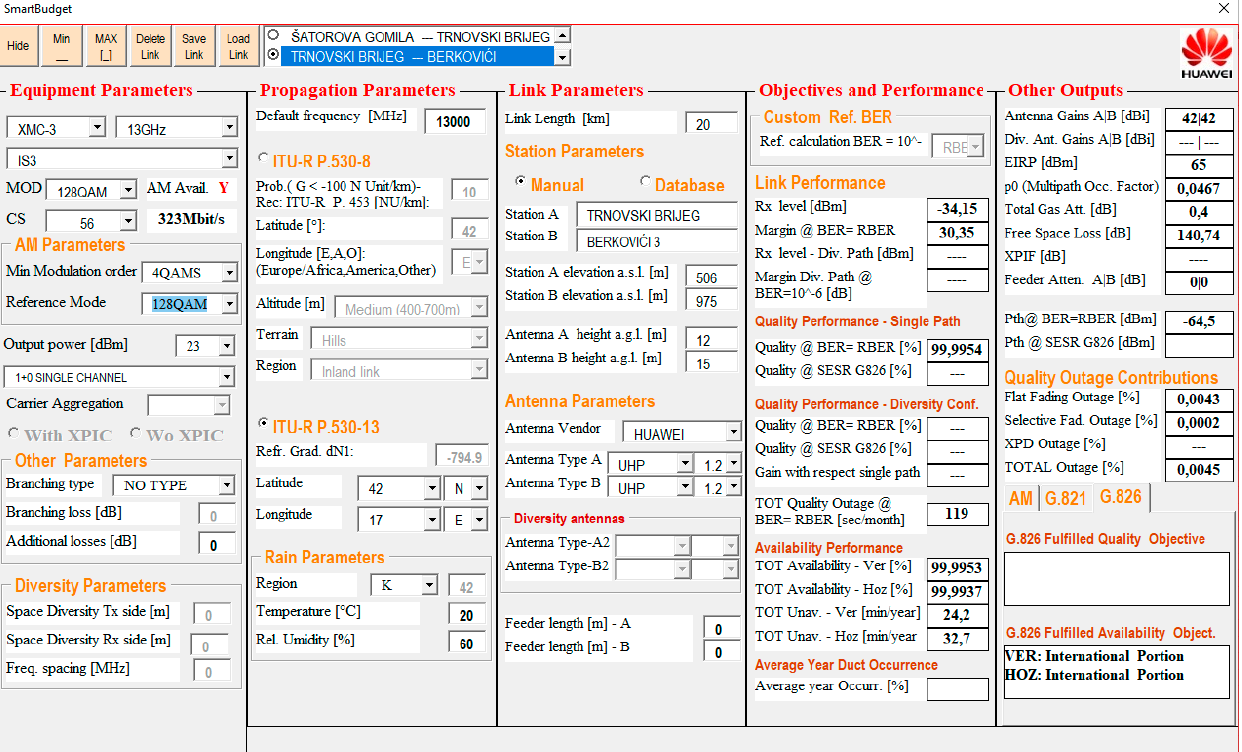
Figure 13. Prediction for the third RR section; 128 QAM, 323 Mb/s. The fourth very short RR section definitely fulfills the norm with 2048 QAM modu- lation and maximal throughput of 500 Mb/s; as for vertical polarization, the annual una- vailability amounts to just 37.8 min (Figure 14).